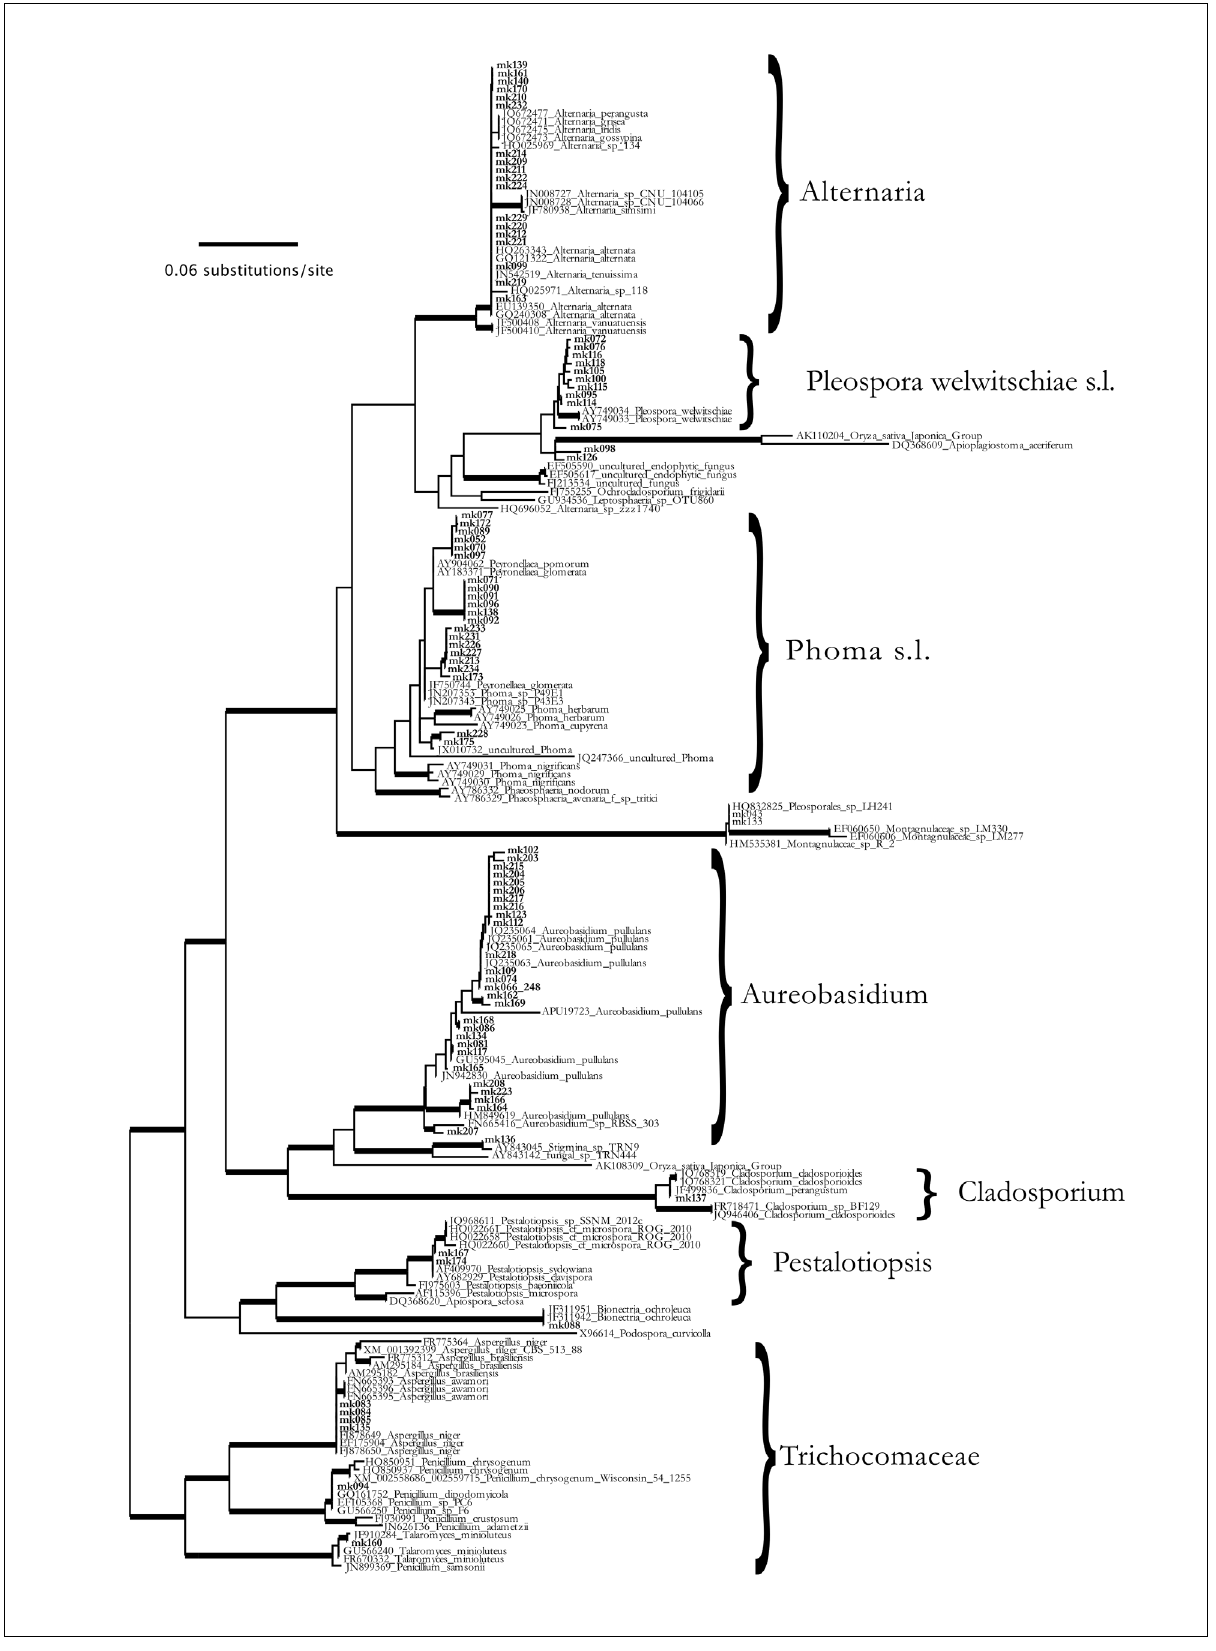
Figure 2: Maximum likelihood reconstruction of Ascomycota groupings isolated from Welwitschia mirabilis based on ITS, elongation factor 1 alpha and beta-tubulin 1. A bootstrap of 1000 was conducted. The phylogeny was rooted with members of Eurotiomycetes. Taxa in bold are from this study. Bold branches indicate bootstrap values ≥70. Major fungal lineages are indicated. See also Supplementary